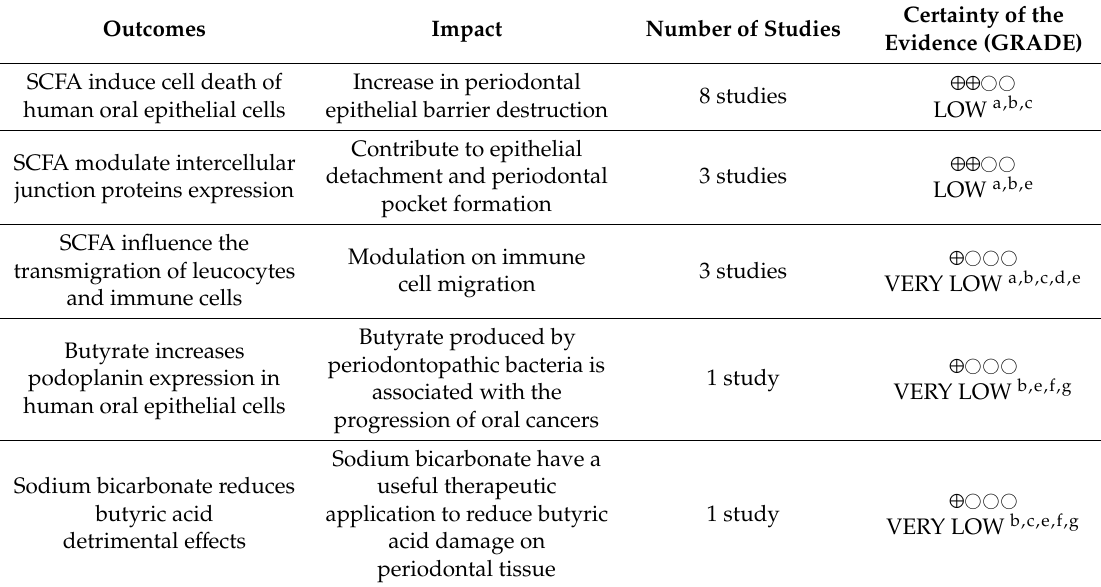
Table 3. Summary of findings based on GRADE certainty of evidence